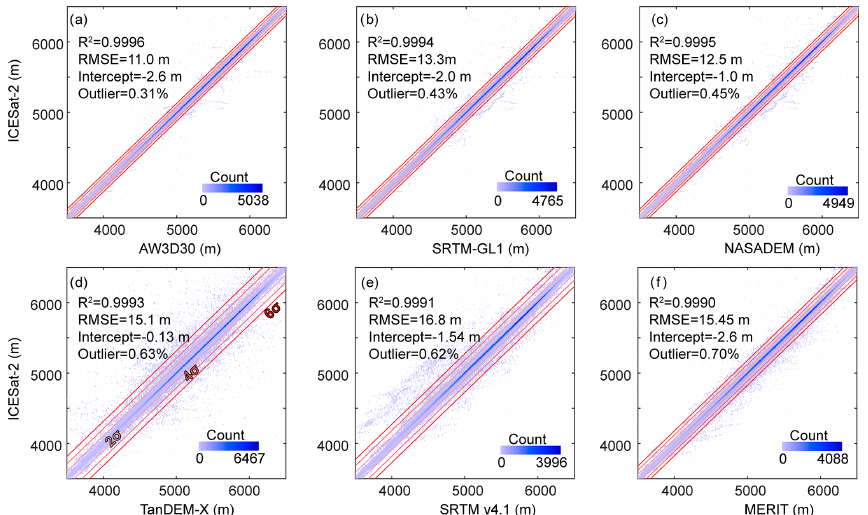
Figure 3. Differences between six DEMs and ICESat-2 elevation. (a) AW3D30, (b) SRTM-GL1, (c) NASADEM, (d) TanDEM-X, (e) SRTM v4.1, and (f) MERIT. The gradually lighter red lines in (d) denote the range within 6, 4, and 2 σ of the mean. The text at the top left of each panel gives the fit results for data within 4 σ of the mean. Outlier denotes the proportion of outliers relative to the total records. R 2 , RMSE, and intercept are fit results when the slope coefficient is set to 1. The elevation range was cut to 3500–6500ma.s.l., the range in which most elevations values are located, to show clearly the effect of using different multiples of the SD from the mean.